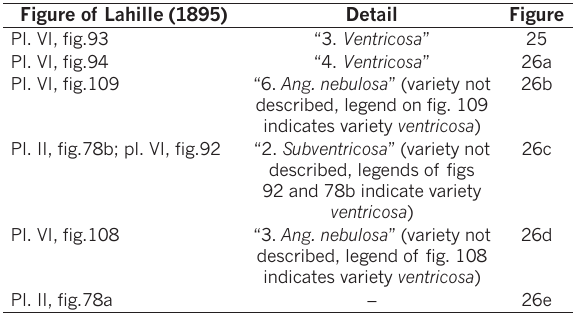
Table 9. Voluta angulata ventricosa , figured by Lahille (1895), with the detail of the inscriptions on their shells and figures